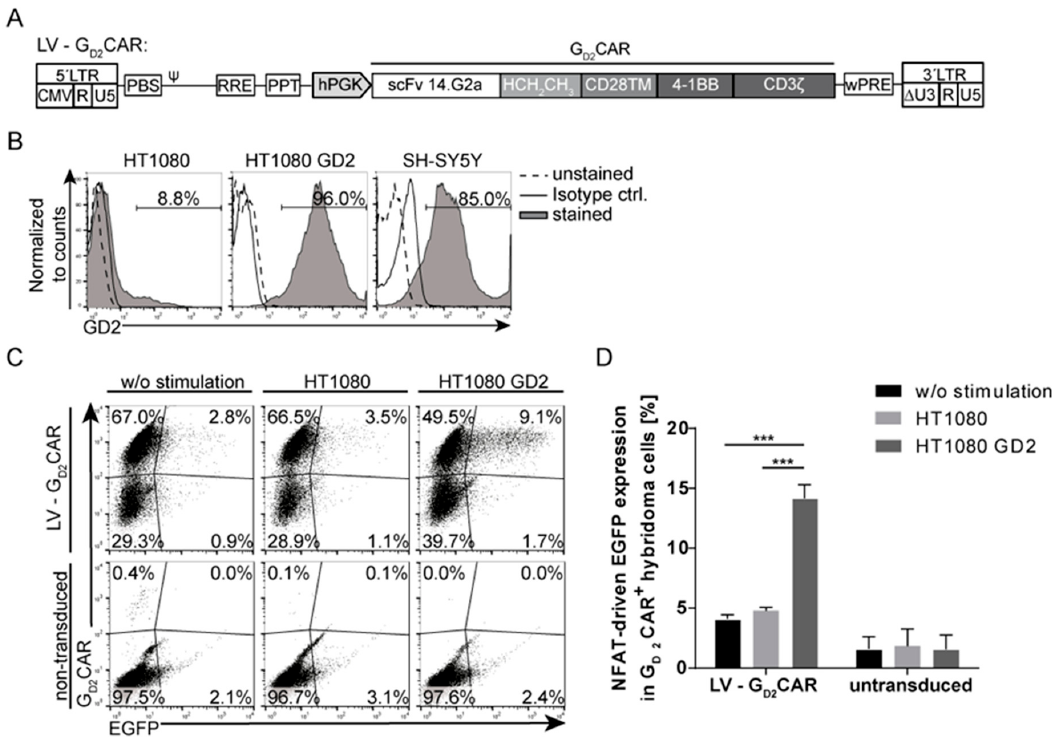
Figure 1. G D2 chimeric antigen receptor (G D2 -CAR)-specific activation leads to nuclear factor of activated T cells (NFAT) promoter-driven enhanced green fluorescent protein (EGFP) upregulation. ( A ) Modular scheme of lentiviral self-inactivating (SIN) vector encoding a second generation G D2 CAR expression cassette driven by the human phosphoglycerate kinase (hPGK) promoter. G D2 CAR consists of the single chain variable fragment (scFv) 14.G2a, the HCH 2 CH 3 hinge domain, the CD28 transmembrane domain (TM), and the 4-1BB / CD3 ζ signaling domain. Depicted is the configuration after integration. Indicated are the long-terminal repeat (LTR) ( ∆ U3, R, and U5), primer binding site (PBS), packaging signal ( ψ ), rev-responsive element (RRE), central poly-purine tract (cPPT), and woodchuck hepatitis virus post-transcriptional regulatory element (wPRE). ( B ) Flow cytometric analysis of G D2 -expressing target cell lines (HT1080 GD2 and neuroblastoma cell line SH-SY5Y) used for co-culture experiments. ( C ) Representative flow cytometric analysis of G D2 CAR-transduced hybridoma cells after co-culture with indicated target cells. NFAT-driven EGFP upregulation was observed after co-culture with GD2 + target cells. Gated on G D2 CAR + hybridoma cells. ( D ) Summary of three independent co-culture experiments showing NFAT promoter-driven EGFP expression in G D2 CAR-transduced hybridoma cells after stimulation with or without GD2 + target cells. Shown are mean values ± SD ( n = 3). Indicated significance was determined by two-way analysis of variance (ANOVA) with Tukey´s multiple comparison test; *** p ≤ 0.001). CMV, cytomegalovirus.